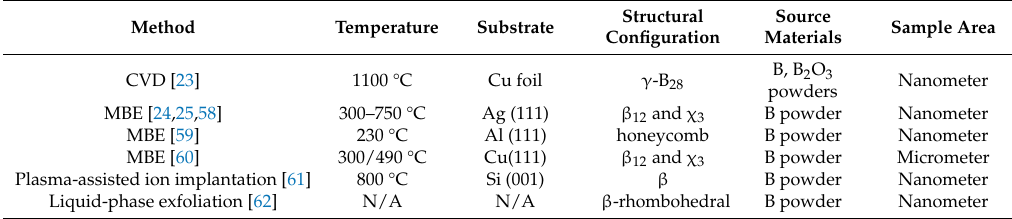
Table 2. The summary table of the synthesis methods of borophene. MBE: molecular beam epitaxy.